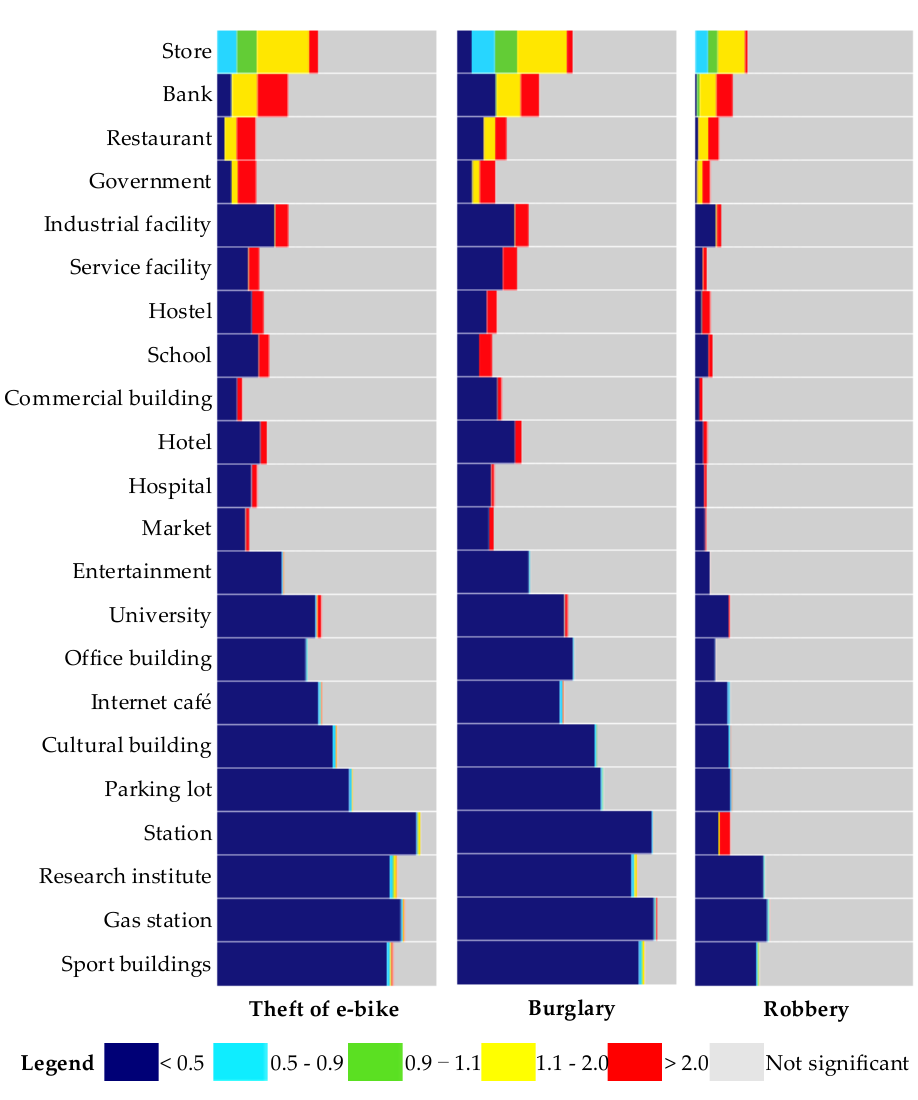
Figure 4. LCLQ comparisons among types of crime and types of land-use feature.